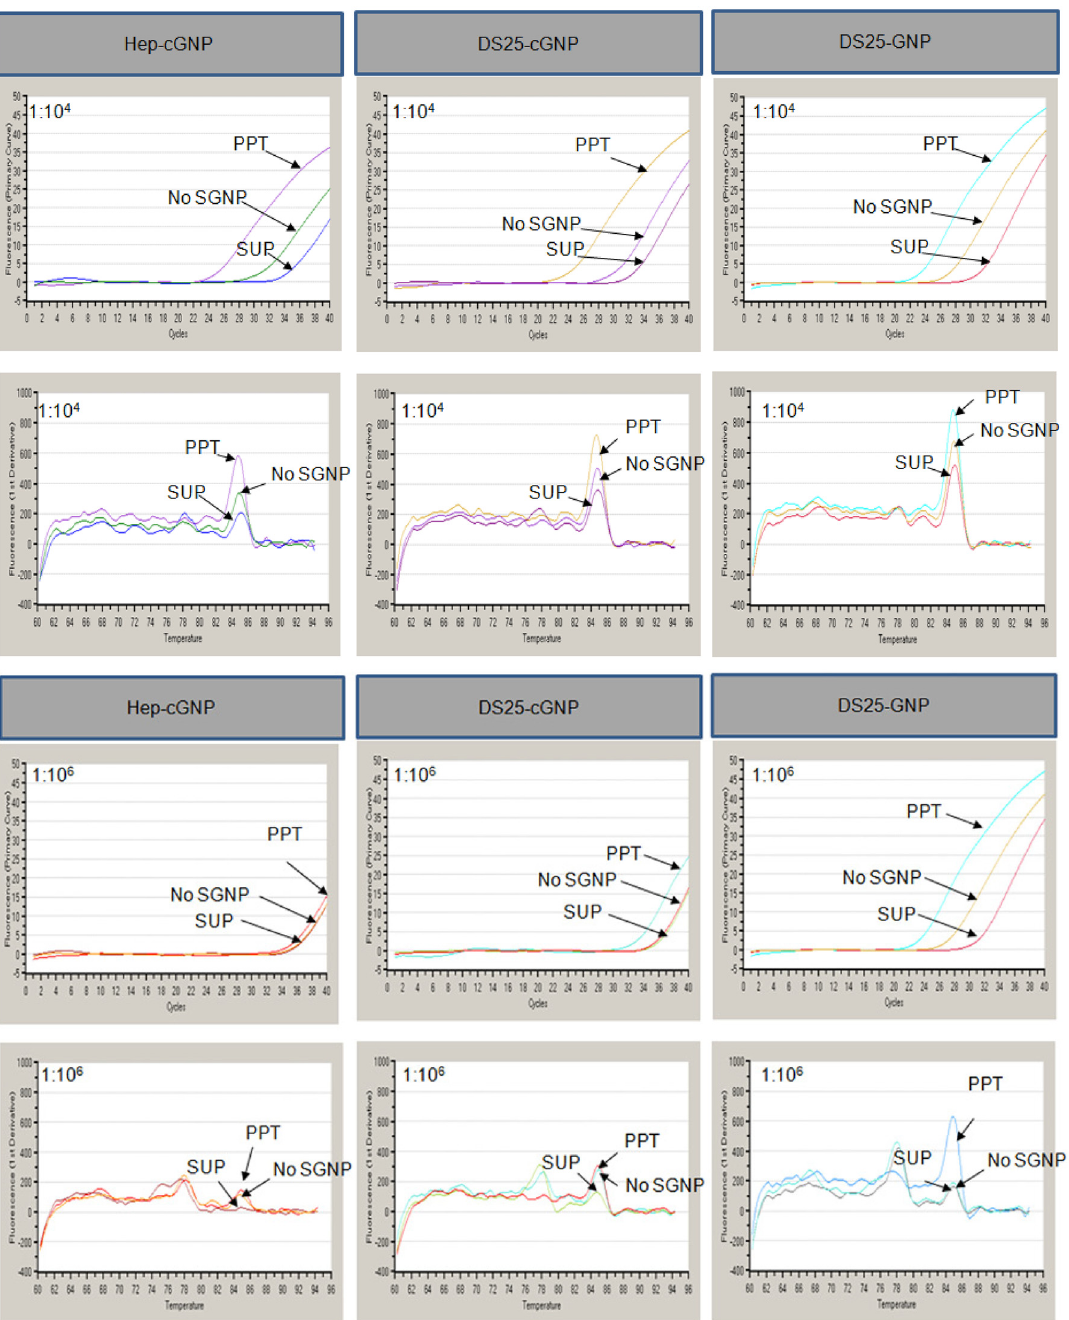
Fig 2. The concentration procedure for dengue virus (DENV) virions using sulfated sugar chain-immobilized gold nanoparticles (SGNPs). A DENV solution was diluted 1:10 4 or 1:10 6 in PBS. PPT, precipitate obtained from the treatment with SGNP; SUP, supernatant obtained from the treatment with SGNP; No SGNP, sample without treatment with SGNP. T m for DENV-1 was 85 ± 0.3°C. Upper: fluorescent intensity vs. cycle number (Ct); Lower: melting curve.